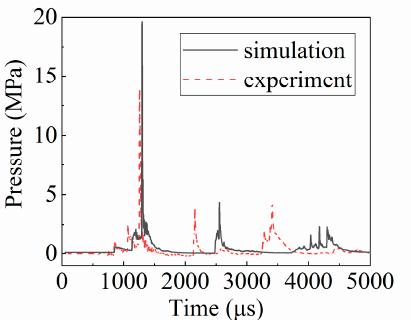
Figure 4. Comparison between the pressure curves of the numerical simulation (black solid line) and the experiment (red dotted line).